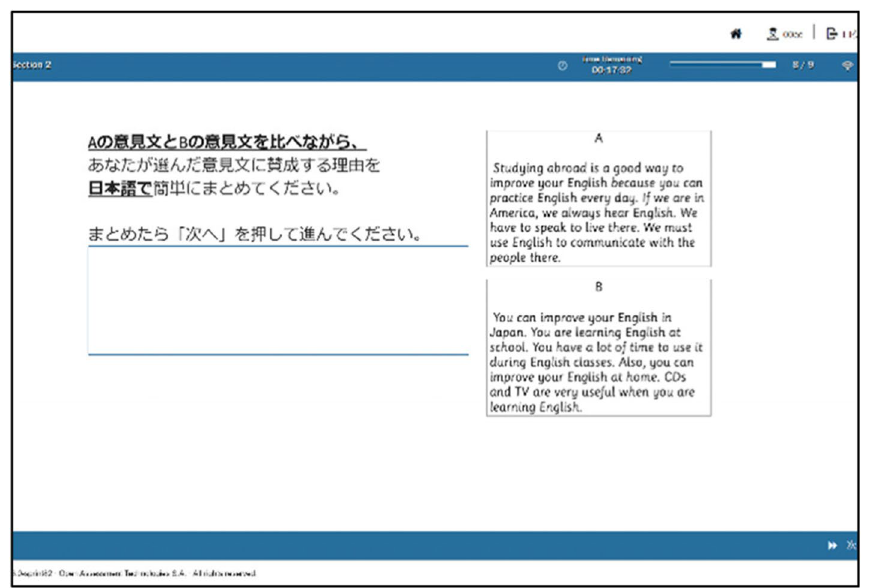
Fig. 7 Screen 6: Organize your ideas in